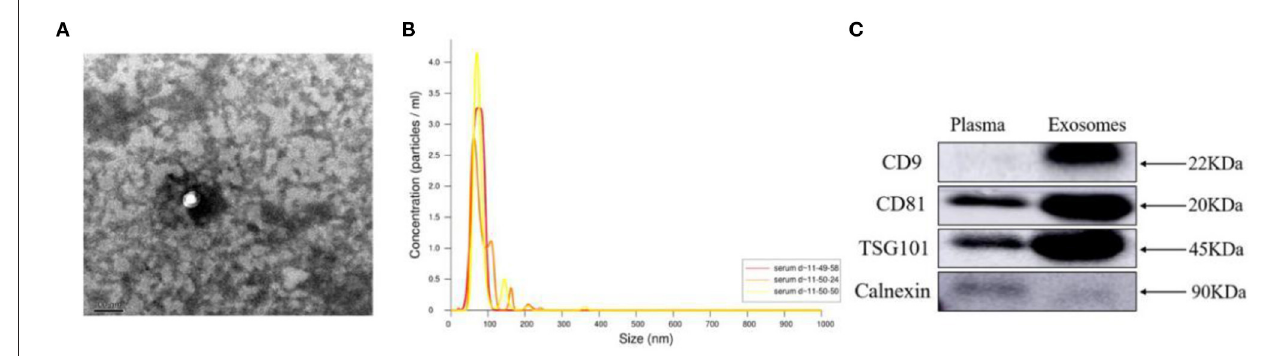
FIGURE 1 | Identification of isolated plasma exosomes. (A) Image of isolated exosomes under a transmission electron microscope. Scale bar = 100nm. (B) The mean diameter was ∼ 79.2nm, and the particle concentration was 1.24 × 10 9 particles/ml as determined by NanoSight analysis. Horizontal axis, particle size (nm); vertical axis, particle concentration (particles/ml). (C) Protein levels of exosomal positive markers CD9, CD81 and TSG101 were significantly increased and negative marker Calnexin was significantly reduced in the exosomes group compared with the plasma